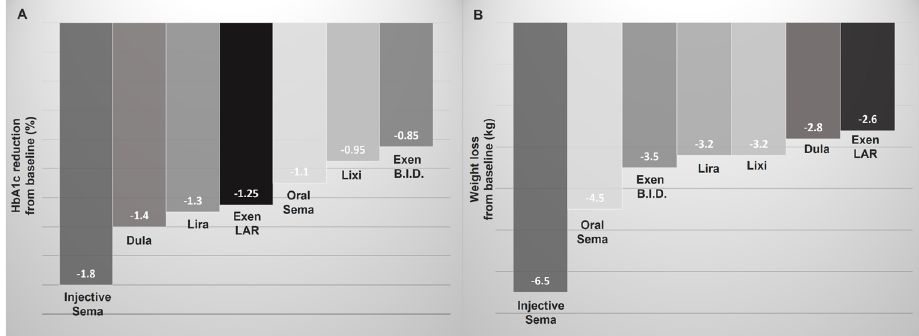
Figure 1. HbA1c and body weight reduction related to the use of GLP-1 RAs in comparative clinical studies. A. Mean HbA1c reduction; B. mean body weight